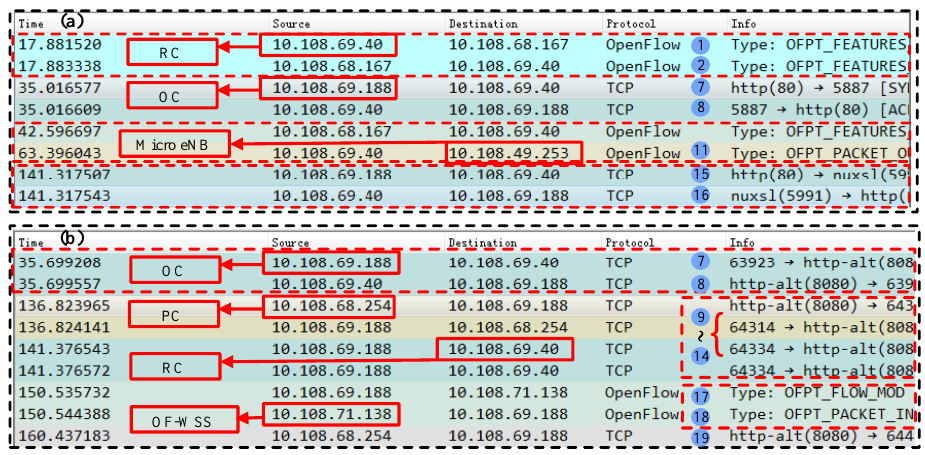
Figure 7. Wireshark capture of the message sequence for CDRA in ( a ) RC and ( b )